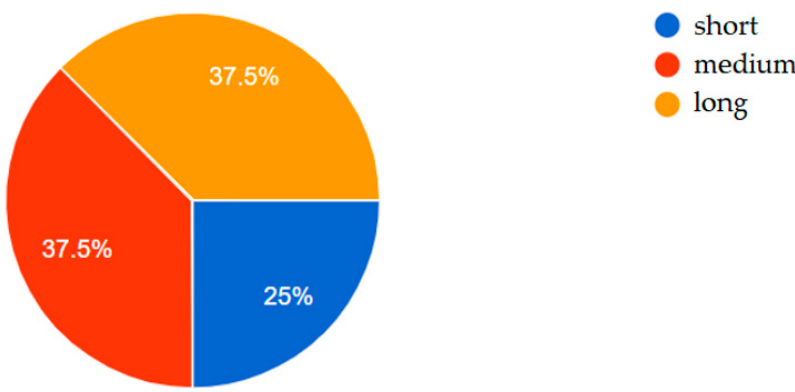
Figure 4. Duration of supply chain disruptions.